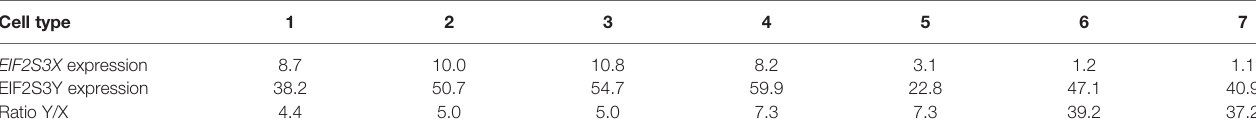
TABLE 1 | During spermatogenesis in mice levels of EIF2S3Y expression signi fi cantly exceed those of EIF2S3X during both early and late stages of sperm development. Cell